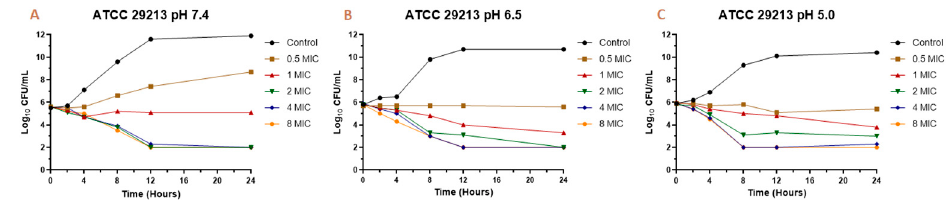
Figure 1. Time-kill curve for Melaleuca armillaris essential oil against Staphylococcus aureus ATCC 29213 at pH 7.4 ( A ), 6.5 ( B ), and 5.0 ( C ).